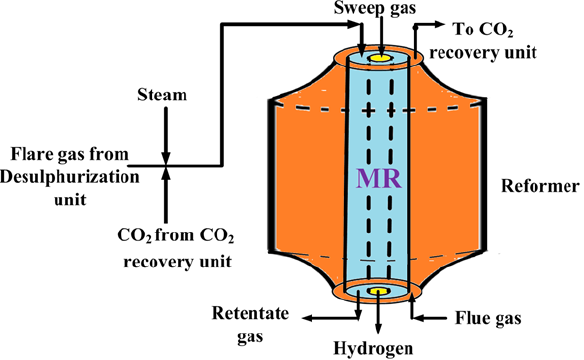
Figure 2. Schematic diagram of the proposed process for hydrogen generation with utilization of flare gas and flue gas.